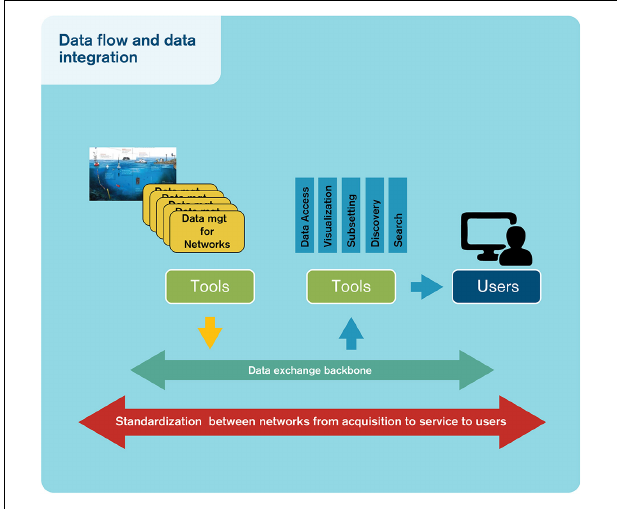
FIGURE 5 | Schematic representation of data flow from observing units through a data exchange backbone to, ultimately,